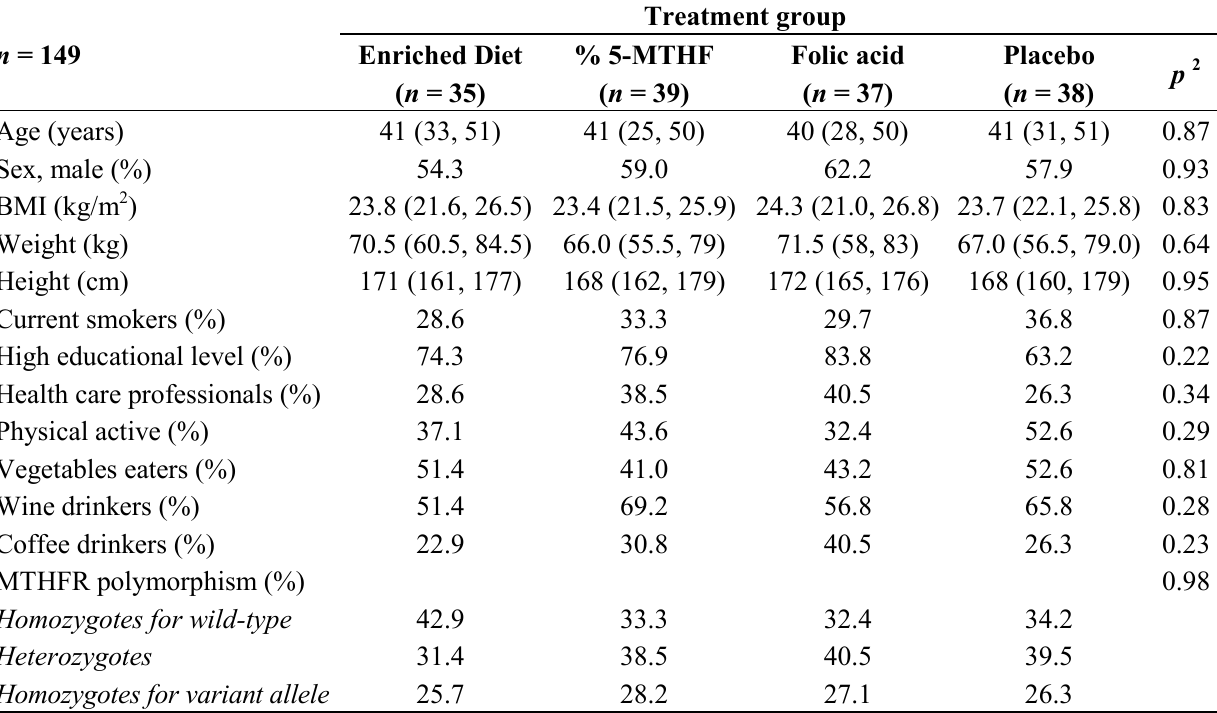
Table 1. Distribution of demographic, anthropometric, life-habits and genetic characteristics of participants according to treatment group 1 .